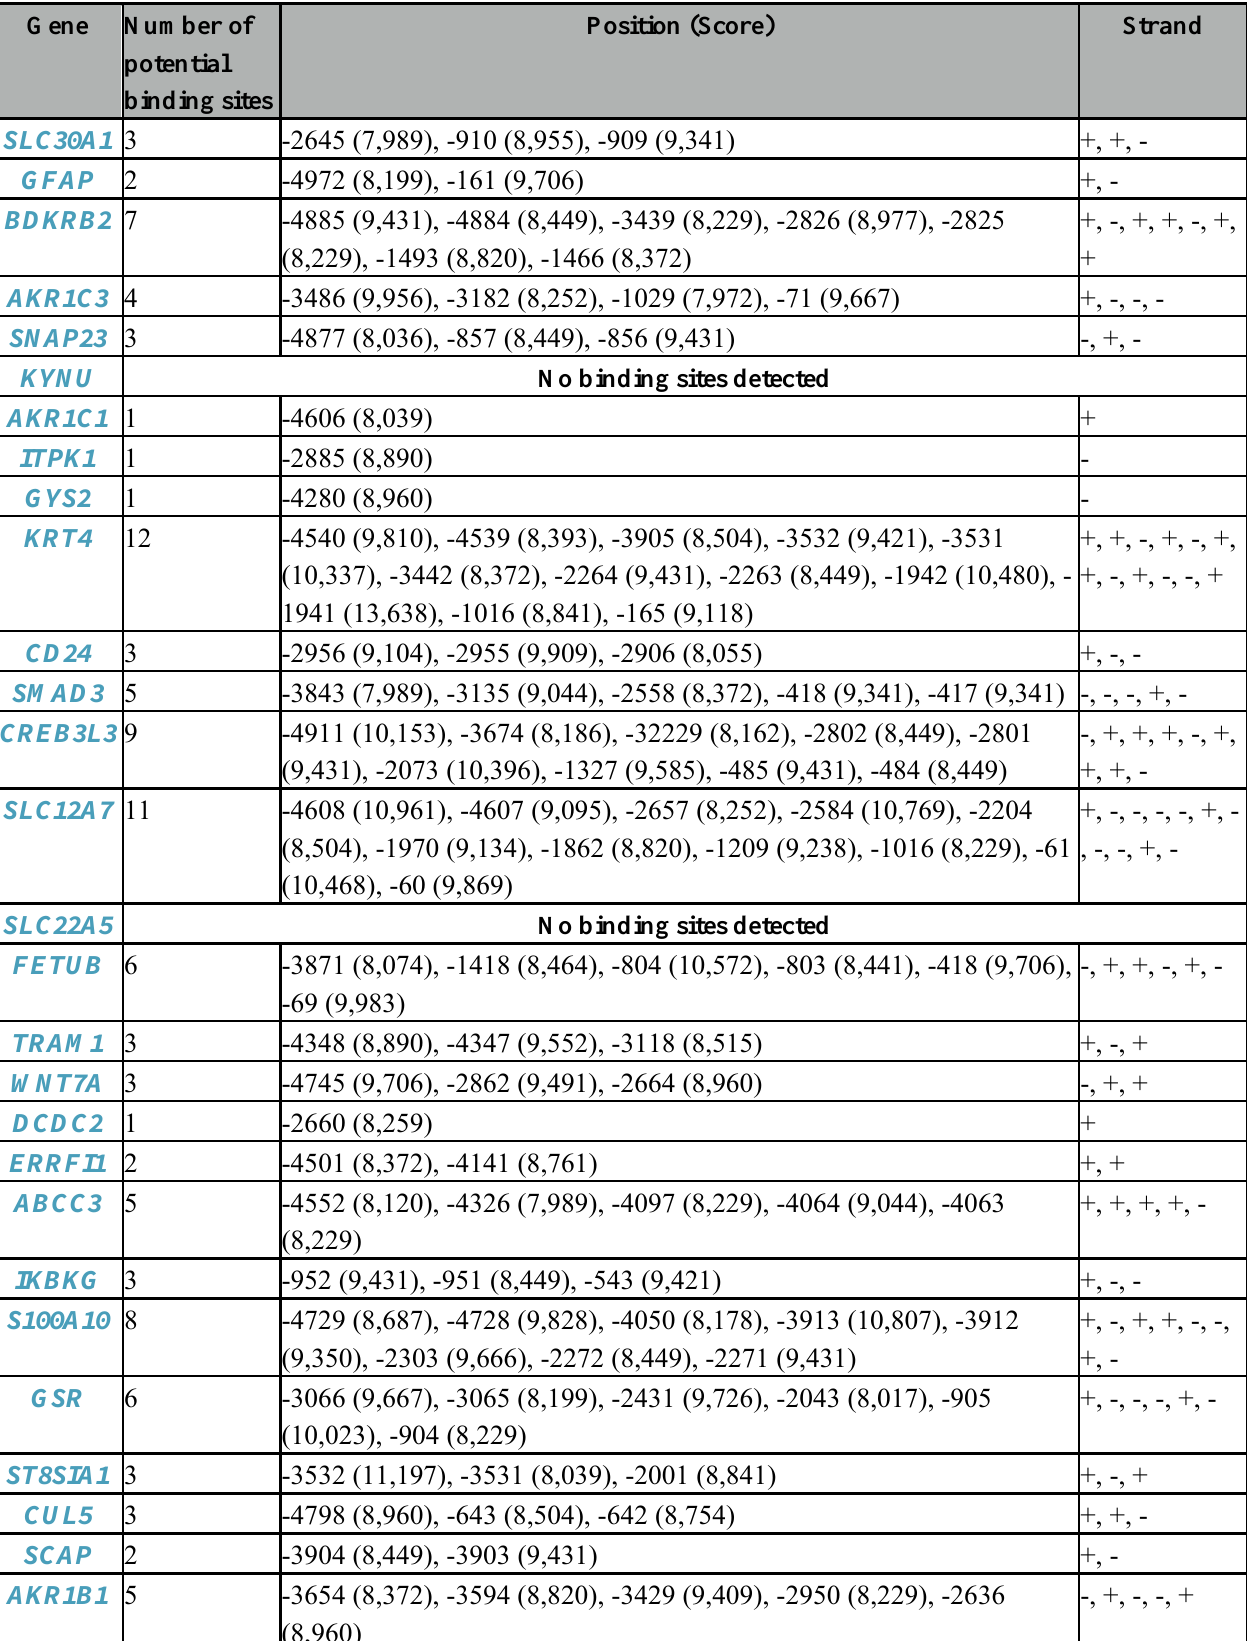
Table 2. Binding sequences of the transcription factor c-Myc upstream of genes identified by microarray mRNA expression profiling ( + , 5’-3’ strand; - , 3’-5’